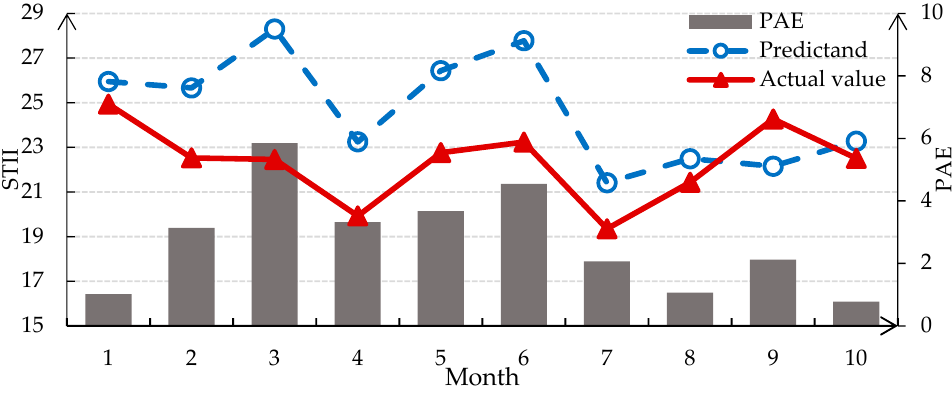
Figure 11. Monthly Prediction of NAST intensity index in the test period.